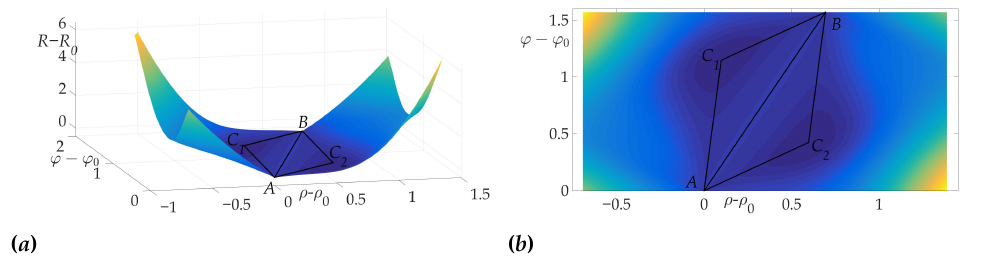
Figure 10. Optimal trajectory in ( ρ − ρ 0 , ϕ − ϕ 0 , R − R 0 ) space ( a ) and its projection on ( ρ − ρ 0 , ϕ − ϕ 0 ) plane ( b ).